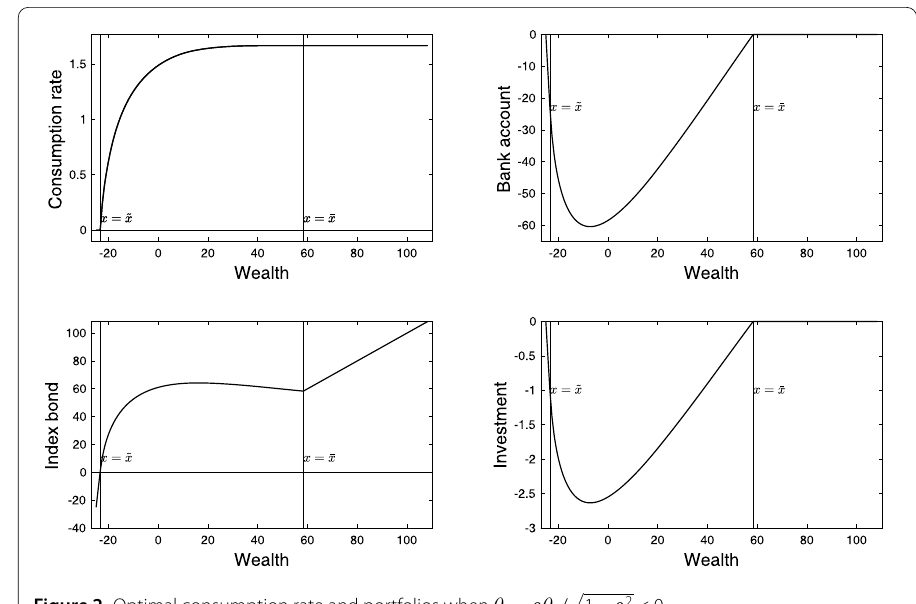
Figure 2 Optimal consumption rate and portfolios when θ 1 – ρθ 2 /